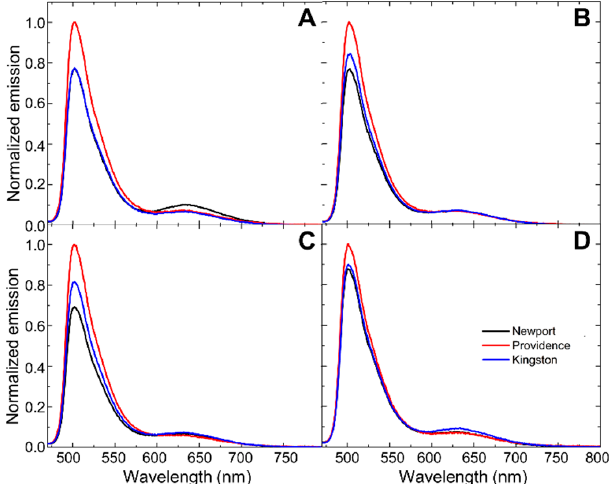
Figure 5. Comparison of the fluorescence response of undoped snow samples with fluorophore 9 ( λ ex = 460 nm) with ( A ) β -cyclodextrin; ( B ) methyl- β -cyclodextrin; ( C ) 2-hydroxypropyl- β -cyclodextrin; and ( D ) phosphate-buffered saline. The black line represents Newport snow, the red line represents Providence snow, and the blue line represents Kingston snow .